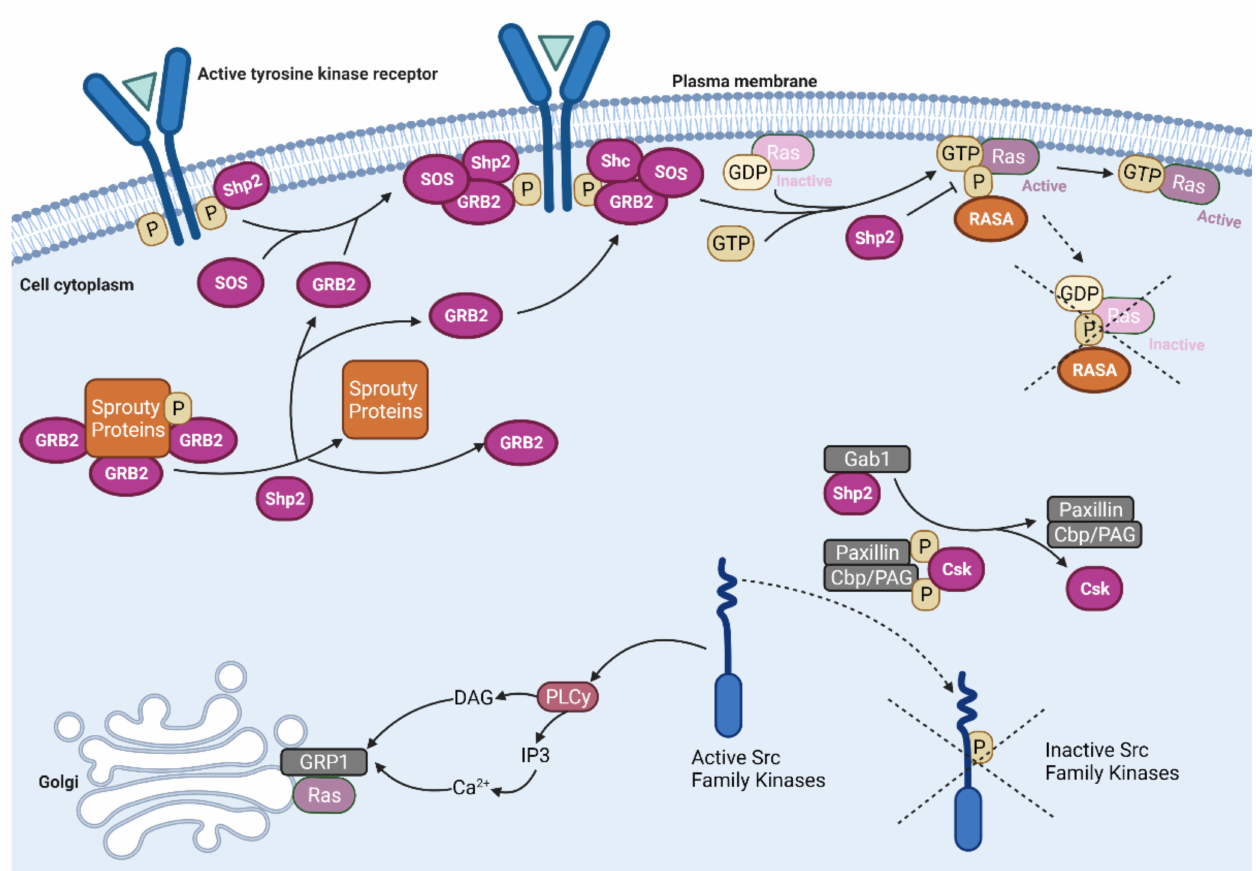
Figure 3. The roles of src homology region 2 domain-containing phosphatase 2 (Shp2) in the Ras-Raf-MEK-ERK pathway. Shp2 is a GRB2 scaffolding protein that anchors it to tyrosine kinase receptors [56]. Additionally, Shp2 dephosphorylates Sprouty family proteins to release sequestered GRB2 molecules [57,58]. It also dephosphorylates Ras docking sites of RASA, a Ras GTPase activating protein (Ras-GAP) that accelerates the hydrolysis of Ras bound GTP [59,60]. This allows more active Ras-GTP molecules to accumulate instead of being converted to inactive Ras-GDP. After being recruited by Gab1, Shp2 can also dephosphorylate the binding sites of Paxillin and the Csk binding protein/phosphoprotein associated with glycosphingolipid-enriched microdomains (Cbp/PAG). This prevents the docking of C-terminal Src kinase (Csk) on